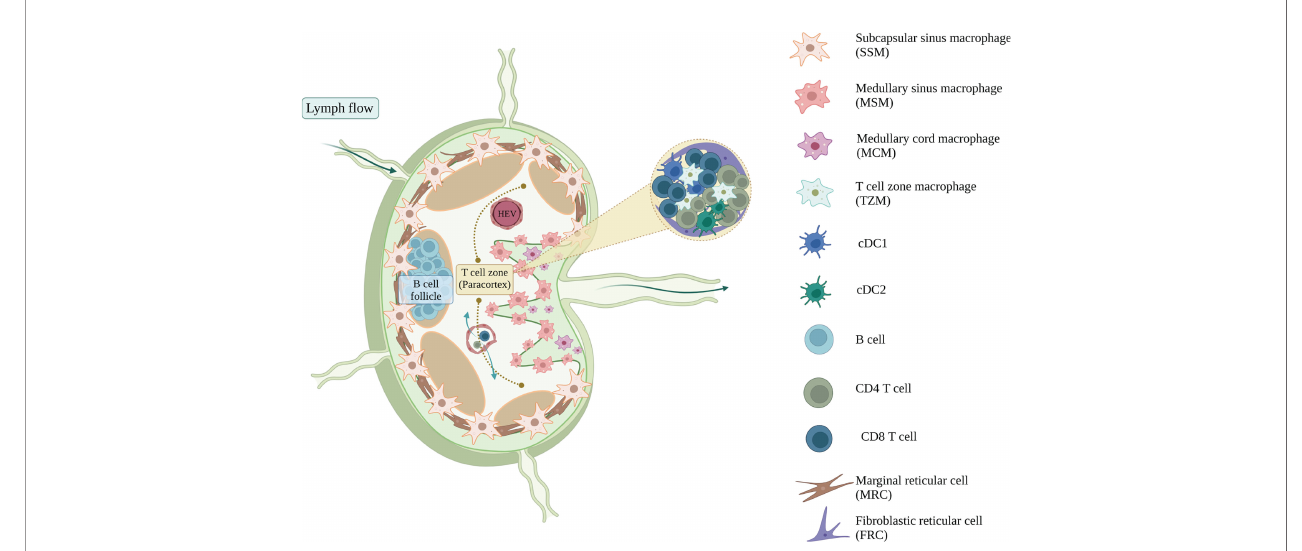
FIGURE 3 | The immune and stromal cell composition of mouse lymph node. Lymph nodes fi lter the lymph and respond to the lymph-borne antigens, from which T and B cells will get activated, proliferate, and provide adaptive immune responses. Myeloid populations of lymph nodes support and regulate this adaptive response and maintain the homeostasis of lymph nodes (97). Subcapsular sinus macrophages (SSM) survey the in fi ltrating lymph before they transduce the activation signals towards the B cells sitting in the B cell follicles (98, 99), whereas cDC1 and cDC2 present the antigens that activate the CD4 + and CD8 + T cells inside the T cell zone, respectively (95). Subsets of lymph node macrophages, including medullary cord macrophages (MCM), T cell zone macrophages (TZM) and tingible body macrophages (TBM), are known for their efferocytotic ability (97, 100). They clear the apoptotic cell debris and maintain the homeostasis of lymph nodes. Lymph node stromal cells also help in regulating tissue homeostasis. Marginal reticular cells (MRC) organize and regulate the B cell follicles, whereas fi broblastic reticular cells (FRC) maintain the T cell homeostasis within the paracortex (101). Figure was created with